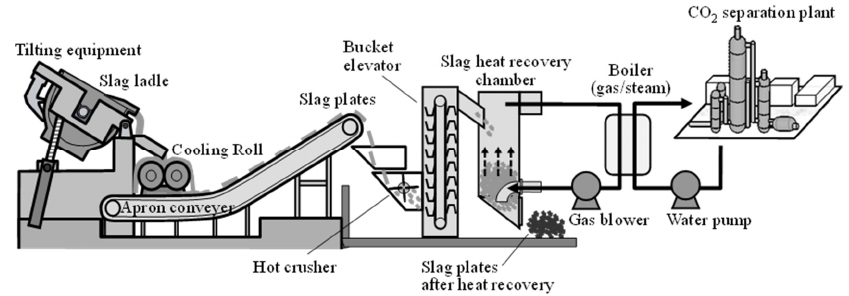
Figure 1. Process drawing of COURSE50 Slag heat recovery system.